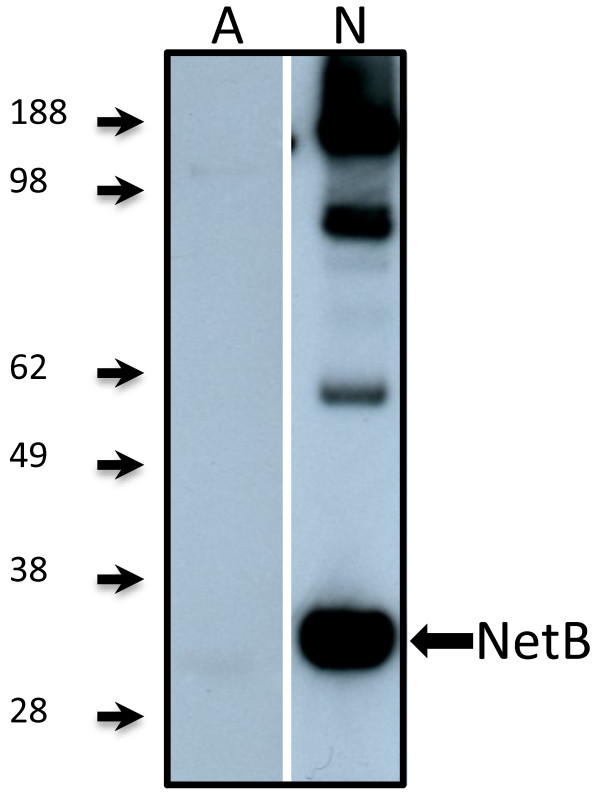
Western blot of serum from broiler chickens immunized with rNetB. Recombinant NetB was electrophoresied on a 4%-12% SDS-PAGE and transferred onto a PVDF membrane. The blot was developed with an ECL Western blotting kit and results recorded on autoradiographic film. SeeBlue Plus2 prestained marker (Invitrogen) was used as a size marker (kDa). Birds were immunized with 50 μg of rNetB with CSIRO Triple adjuvant (days 7 and 17) and serum collected on day 28. A, probed with sera from birds vaccinated with adjuvant only; N, probed with sera from birds vaccinated with rNetB in adjuvant.